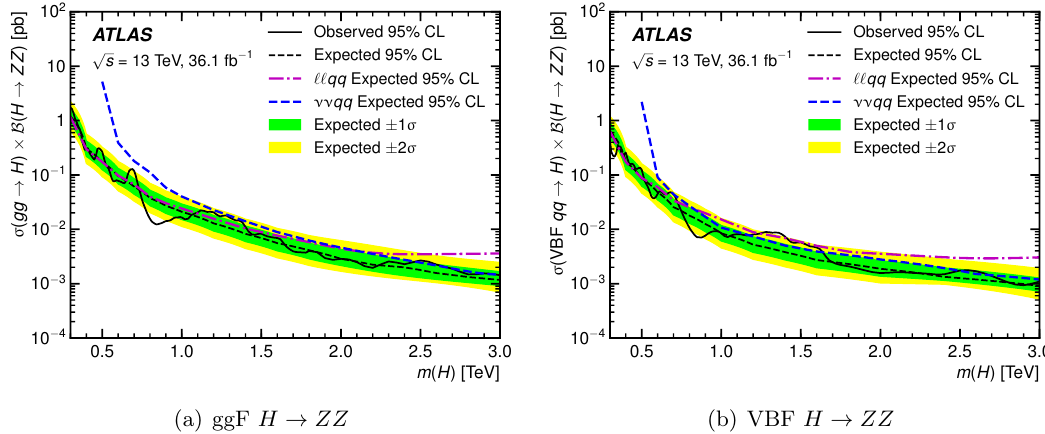
Figure 12 . Observed (black solid curve) and expected (black dashed curve) 95% CL upper limits on (cid:27) ( H ZZ ) at p s = 13 TeV for the (a) ggF and (b) VBF production of a heavy Higgs (cid:2) B ! boson as a function of its mass, combining ‘‘qq and (cid:23)(cid:23)qq searches. Limits expected from individual searches (dashed curves in blue and magenta) are also shown for comparison. Limits are calculated in the asymptotic approximation below 2 TeV and are obtained from pseudo-experiments above that. The green (inner) and yellow (outer) bands represent the expected limits.